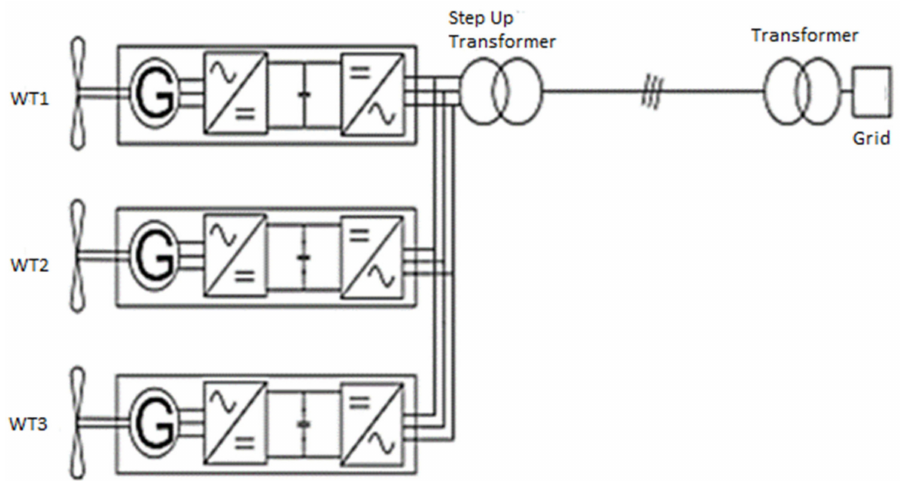
Figure 4. Standard PMSG AC wind farm circuit topology [Reprinted/adapted with permission from Ref. [5]. 2021, IEEE].